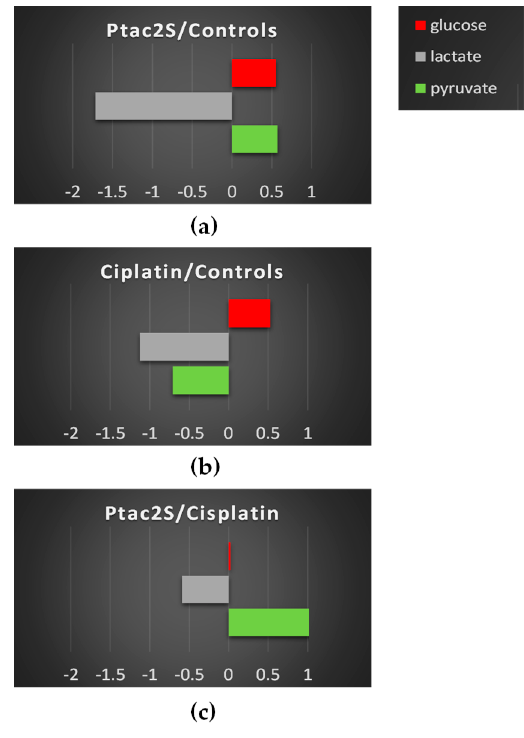
Figure 11. Relevant discriminant metabolites comparison of the culture media of treated, with either Ptac2S, cisplatin , and untreated (controls) SKOV-3 cells. The values of − Log 2 (FC) and the p -values < 0.05 are provided (Student’s t -test). ( a – b ) Metabolites with − Log 2 (FC) negative values have a lower concentration compared to those of the 24 h control, while − Log 2 (FC) positive values have higher concentration compared to those of the 24 h control. ( c ) Metabolites with − Log 2 (FC) negative values have a lower concentration compared to those of the 24 h cisplatin group, while − Log 2 (FC) positive values have a higher concentration compared to those of the 24 h cisplatin group.